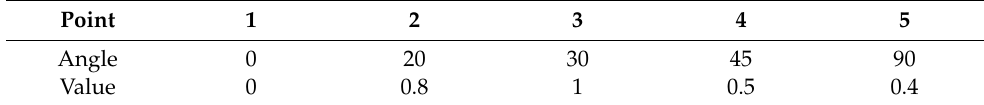
Table 1. Parameters of the impact angle function.